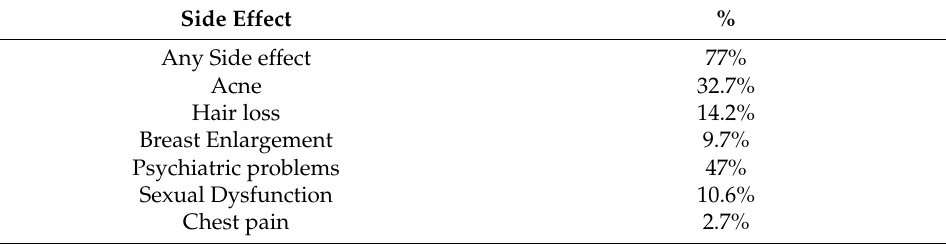
Table 2. The prevalence of side effects experienced by users. Side Effect %